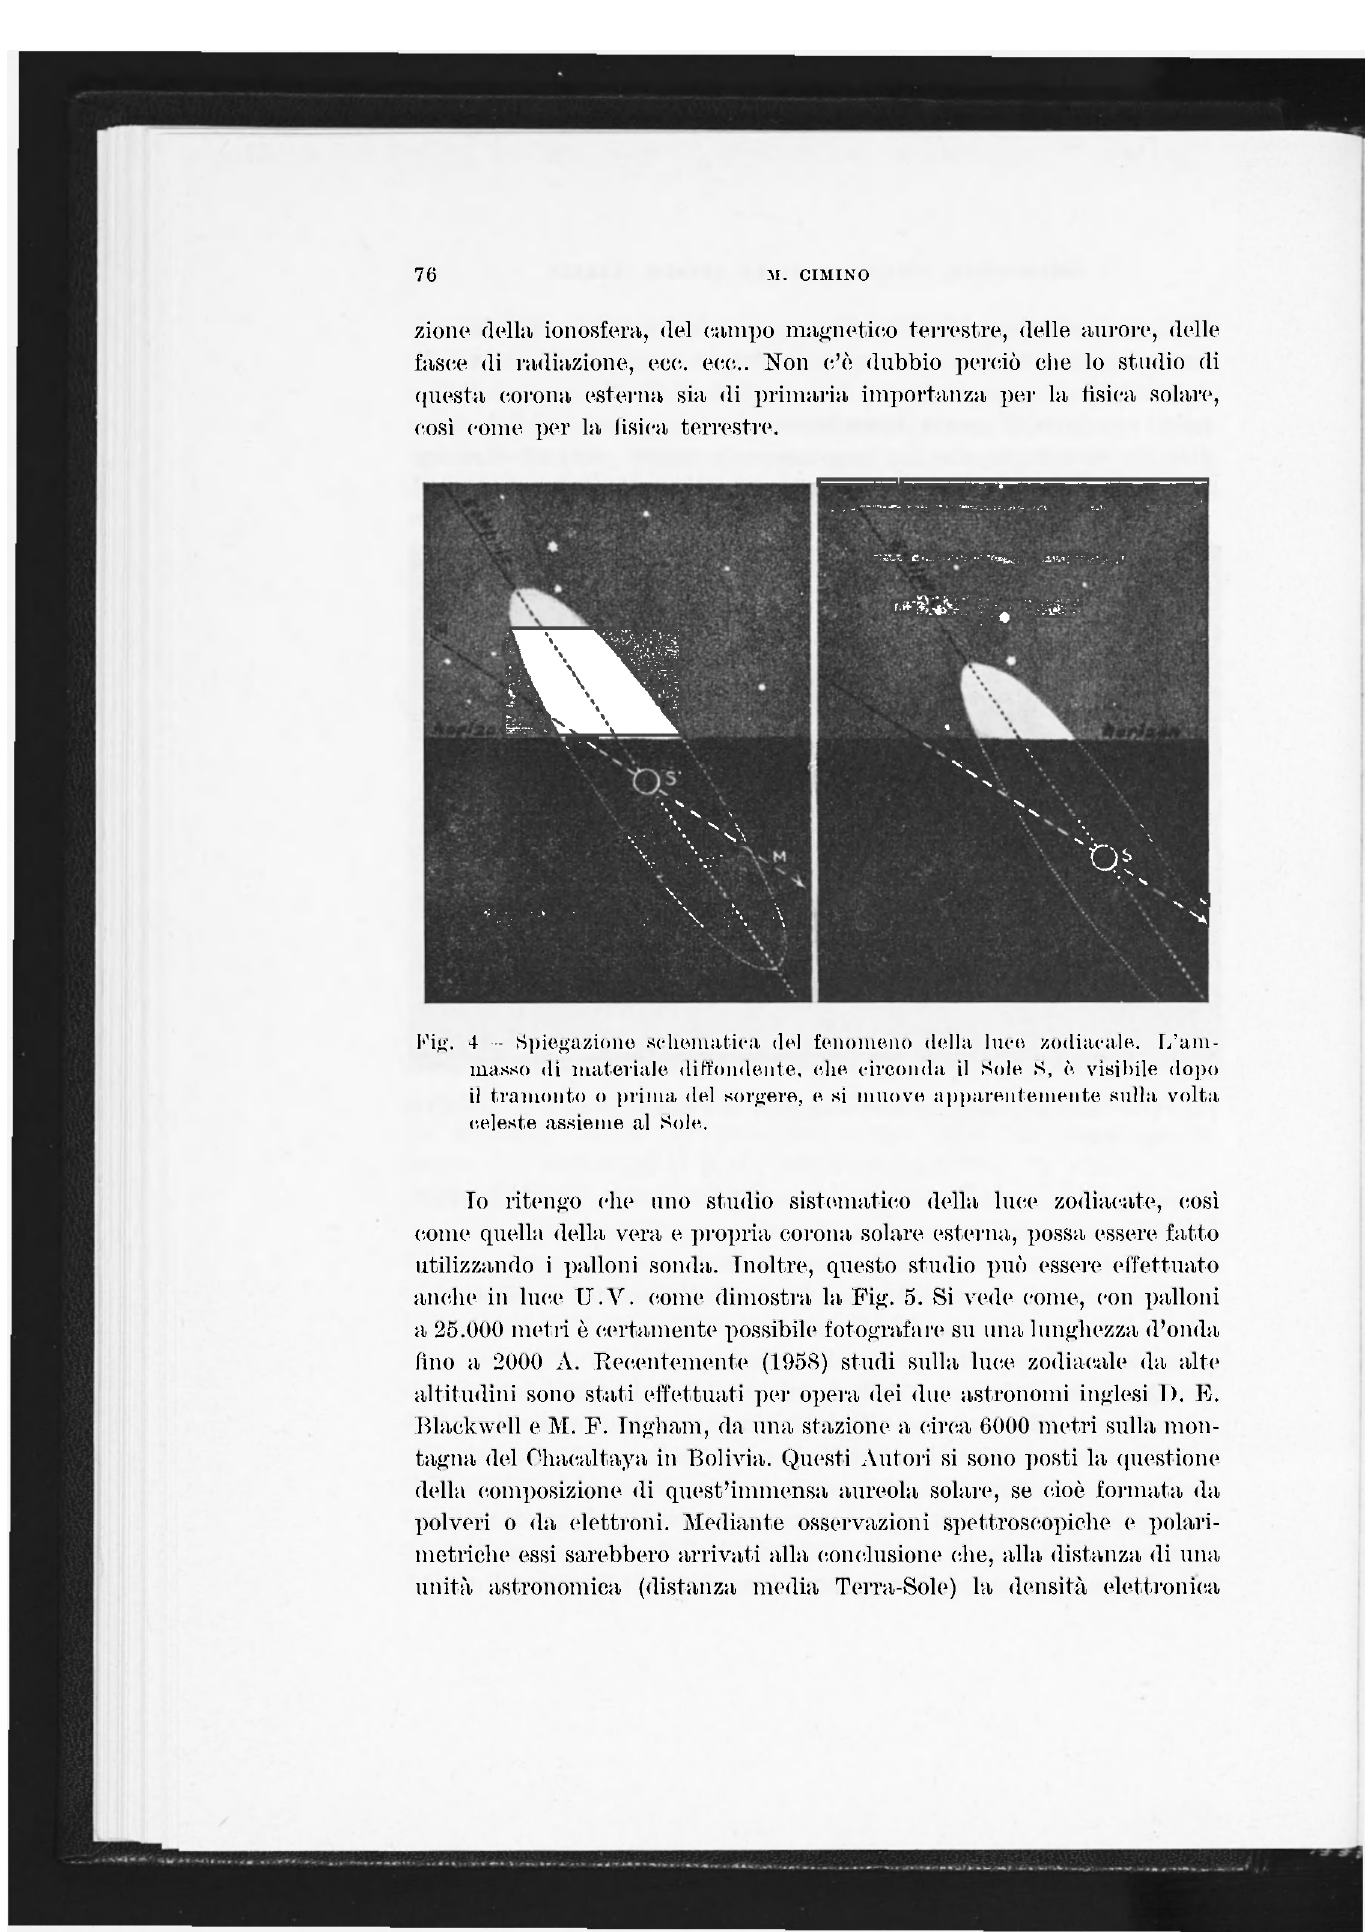
Fig. 4- - Spiegazione schematica (lei fenomeno della luce zodiacale.